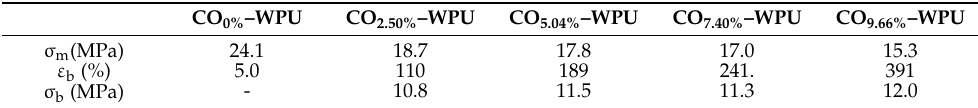
Figure 7. Tensile stress–strain curves of WPUs with different content of CO . Table 3. Mechanical property of WPUs